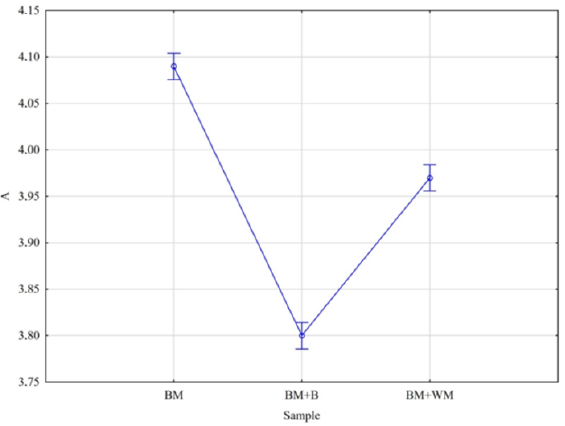
Figure 6. Mean contents of organic matter (OM) in BSG. Figure 7. Mean contents of organic matter (A) in BSG. Figure 7. Mean contents of organic matter (A) in